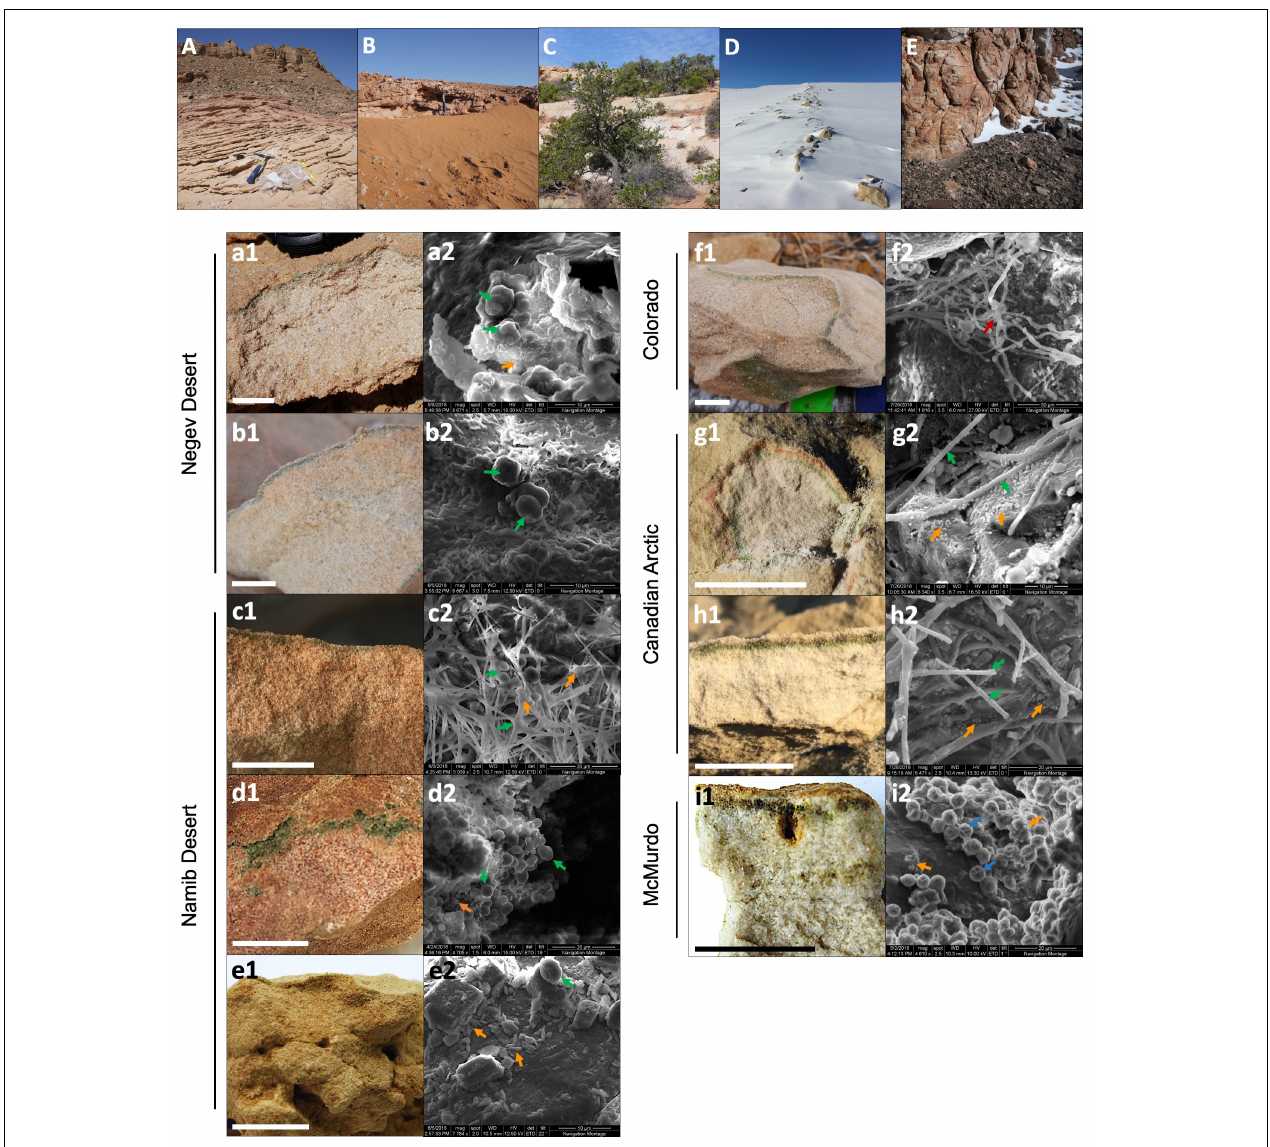
FIGURE 2 | Location, colonization zone, and SEM micrographs of microbial communities from each sampling site. (A–E) General views of the five deserts sampled: (A) Negev Desert, (B) Namib Desert, (C) Colorado Plateau, (D) Canadian Arctic, and (E) McMurdo Dry Valleys. (a1–i1) Sandstone colonization zone at each site, in the order: (a) Timna Park, (b) Ramon Crater, (c) Namib Coastal, (d) Namib Central, (e) Namib Far East, (f) Escalante, (g) Eureka, (h) Cape Bounty, (i) University Valley. Scale bar = 2 cm. (a2–i2) SEM micrograph images of the endolithic microbial communities. Arrows point to morphologies consistent with cyanobacterial forms (green), fungal hyphae (red), green algae (blue), and heterotrophic bacteria-like cells